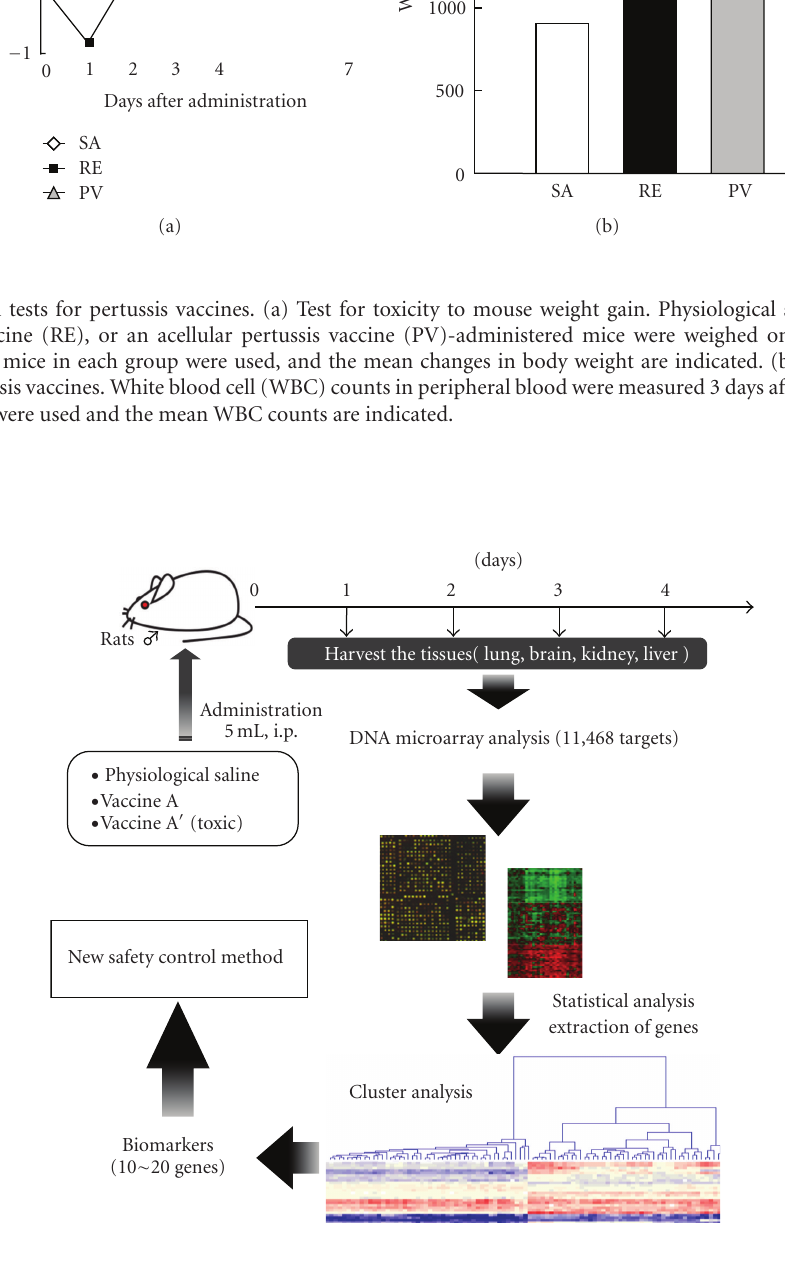
Figure 2: The gene expression analysis procedure. The detail of the procedure is described in the